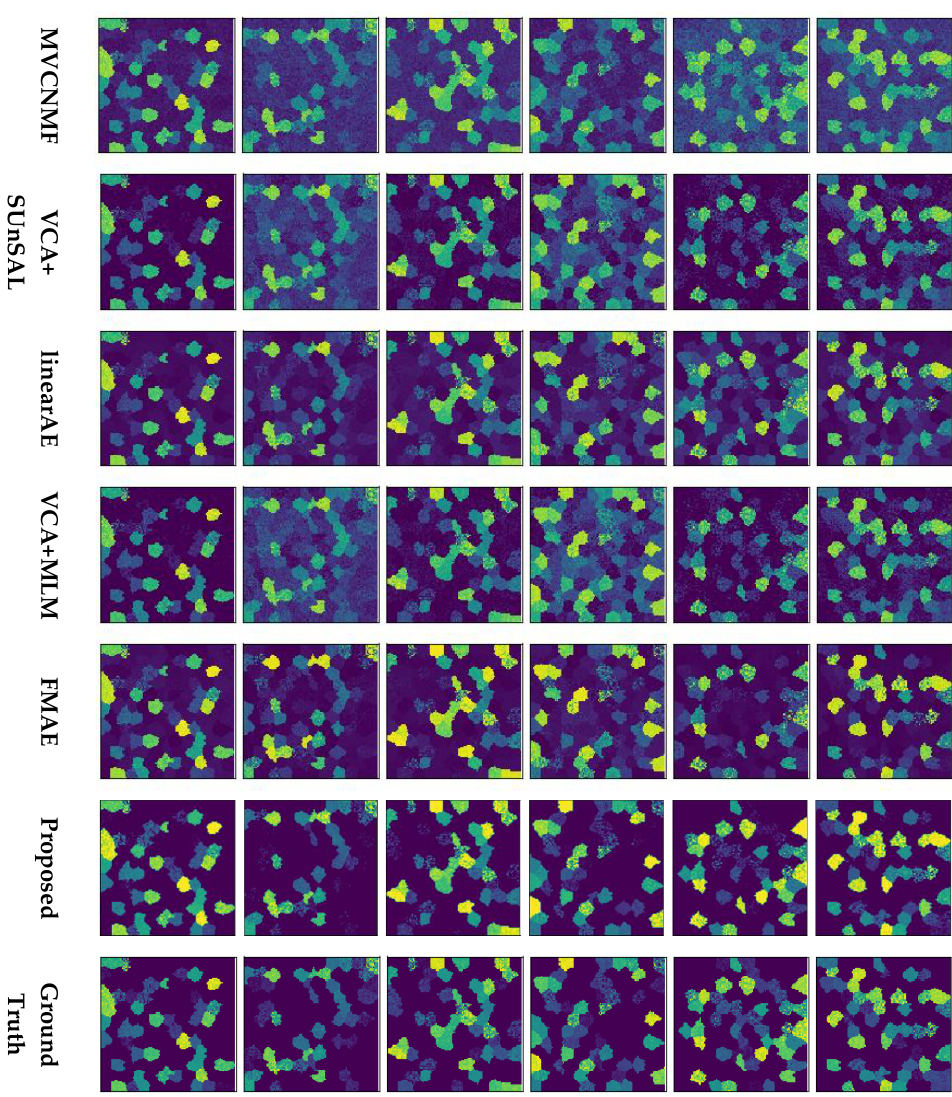
Figure 4. Comparison of the reference endmember (red line) with the endmember extracted by GBM_AE (blue line) on Nonlinear Mixed Data.